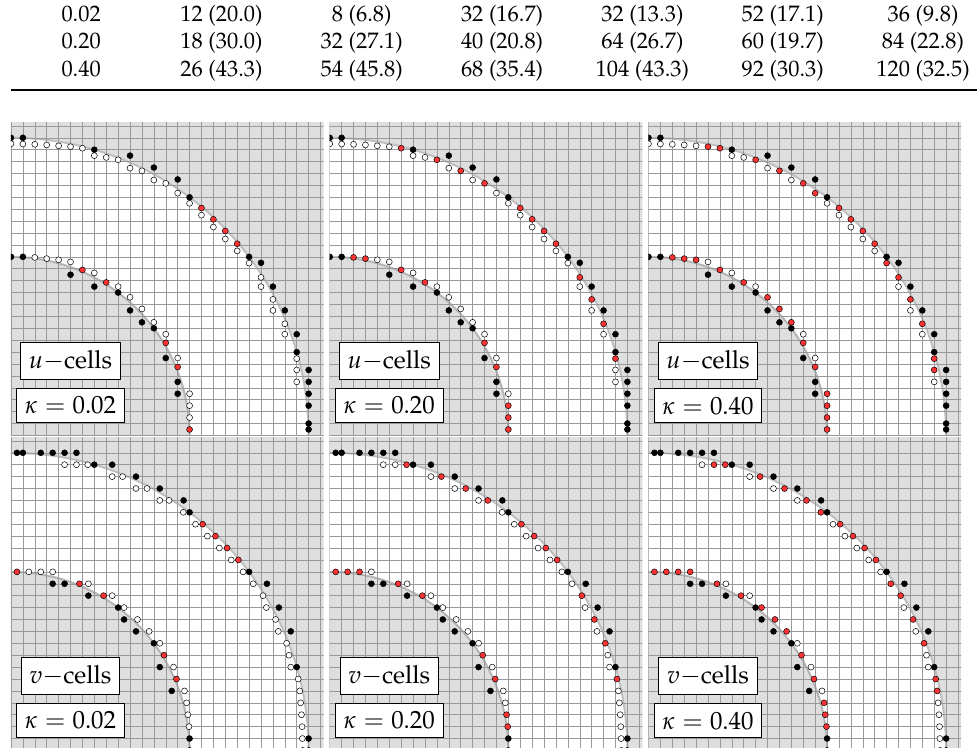
Figure 11. Fluid (white), solid (black) and slave (red) cells distribution around the immersed solids for the flow between cylindrical walls case with the 122 × 122